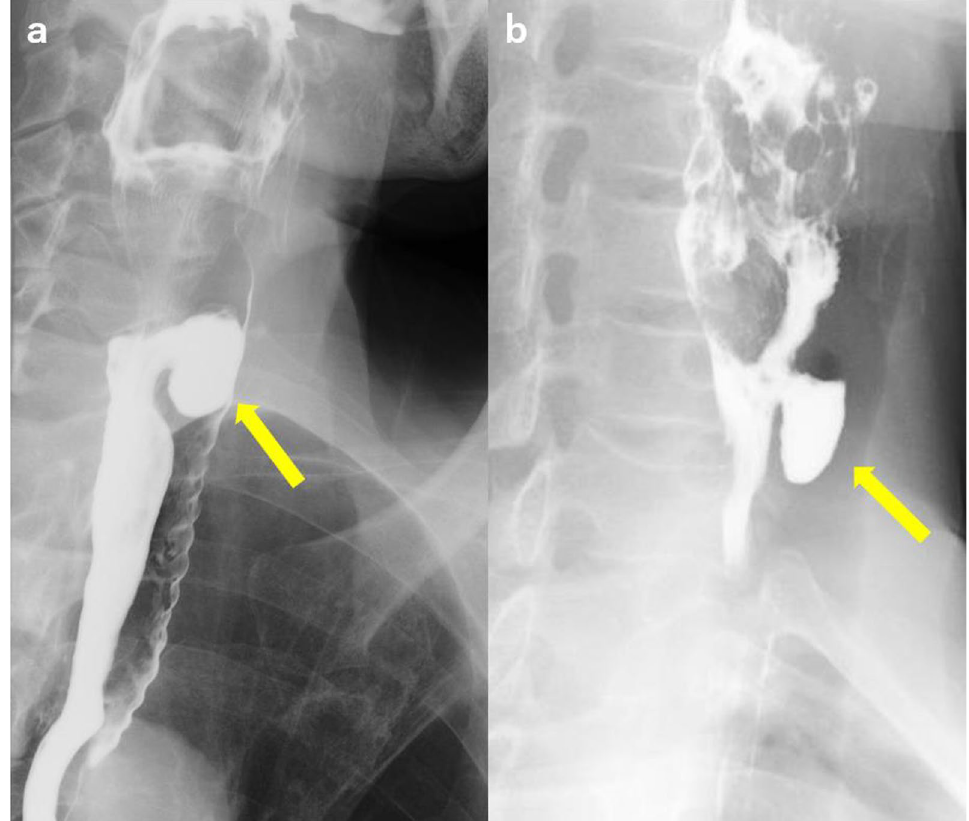
Fig. 4 Comparison of esophagogram between Zenker diverticulum (arrow in a ) and Killian–Jamieson diverticulum (arrow in b